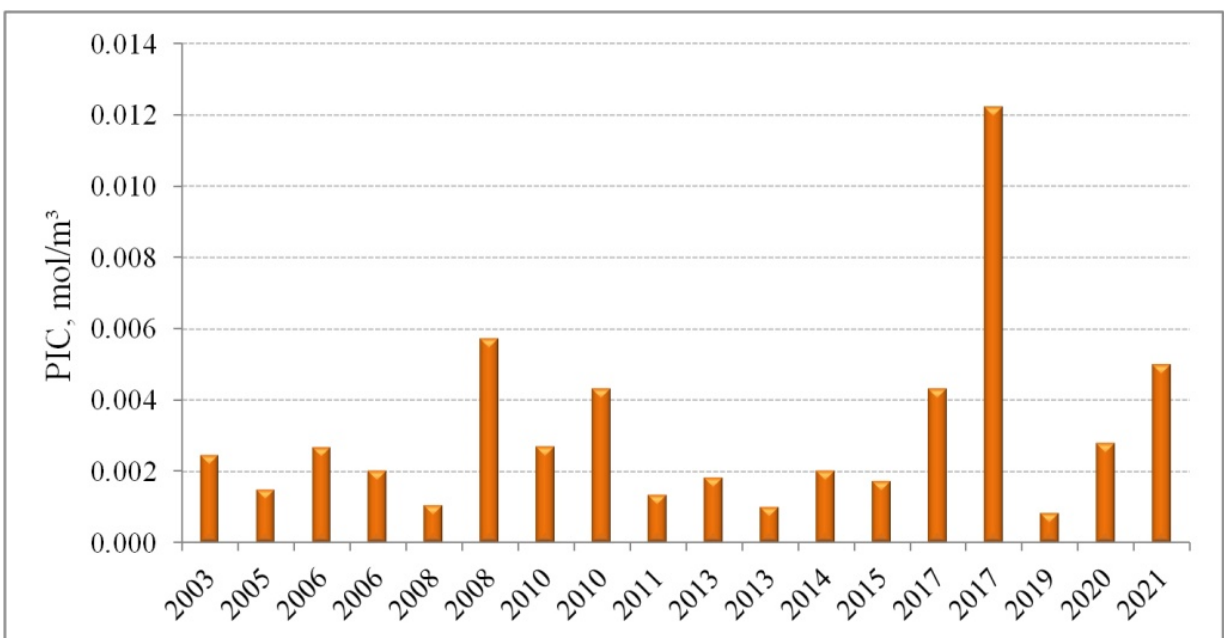
Figure 11. Long term changes in average monthly PIC concentrations in June in the waters of the western shelf of the Black Sea.